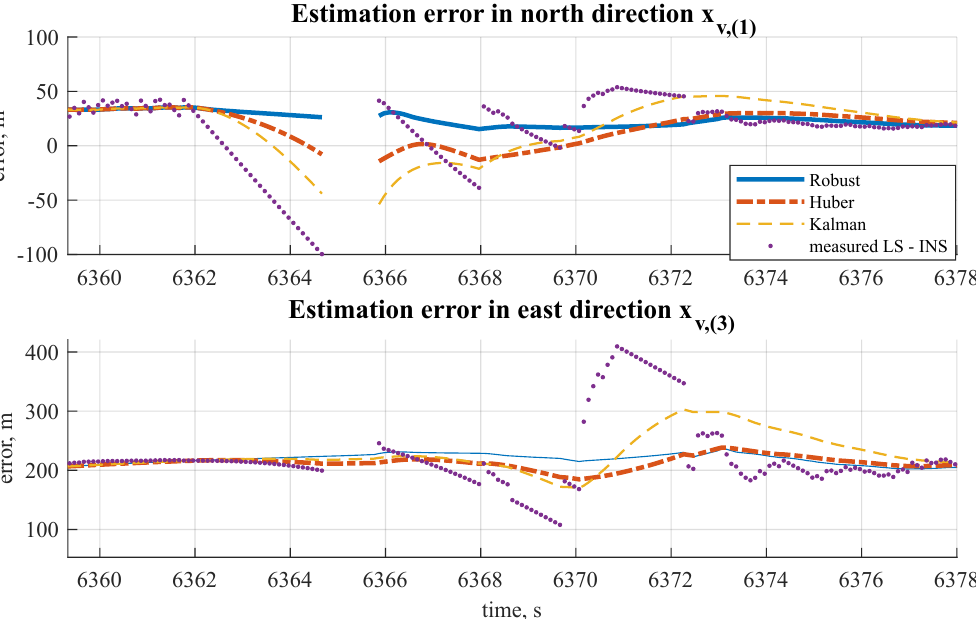
Figure 10. Filter response to anomalous complex shape error in landing system measurements. «Robust»—the proposed robust algorithm. «Huber»—M score.